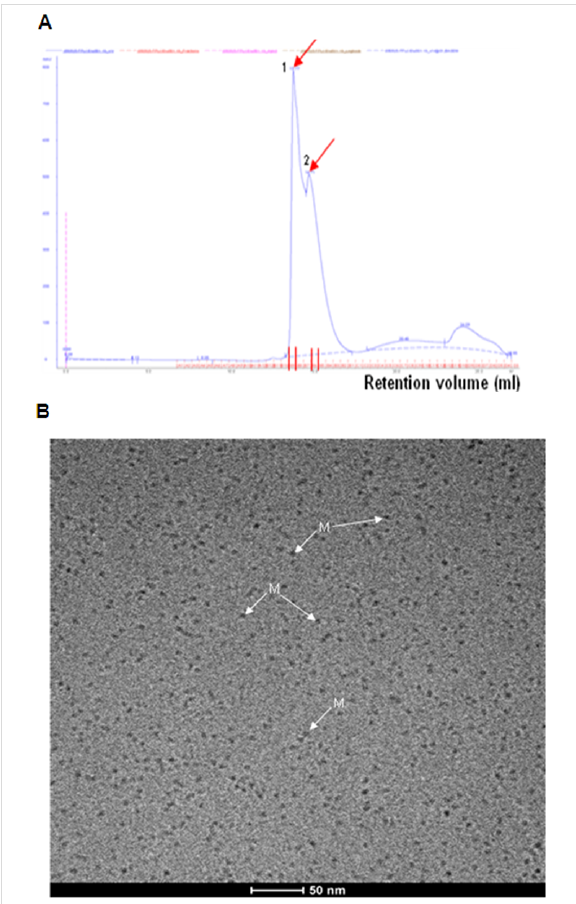
Figure 5: Characterization of the GAT1/GFP fusion protein after SE-FPLC. (A) Elution profile of GAT1/GFP protein after SE-FPLC on a Superdex 200 TM column. (B) Cryo-TEM image of fraction peak 2. Assumed monomeric GAT1/GFP fusion proteins (M, diameter = 5–6 nm) are indicated with white arrows. The control experiment revealed no significant population of spherical